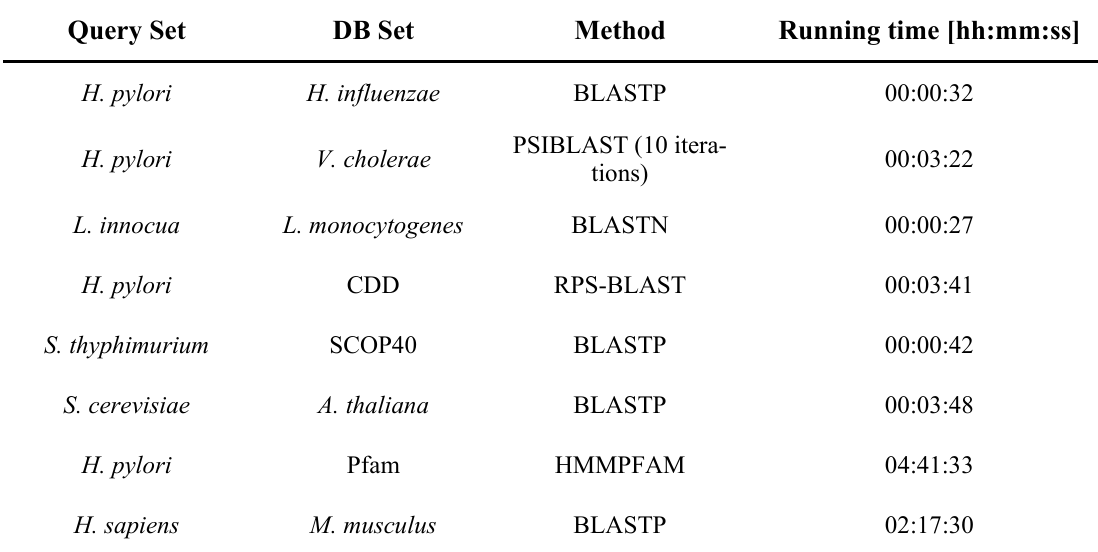
Table 3: Running times for different comparison methods using the Genlight virtual cluster sys- tem with 25 Sun Ultra SparcII CPUs on different